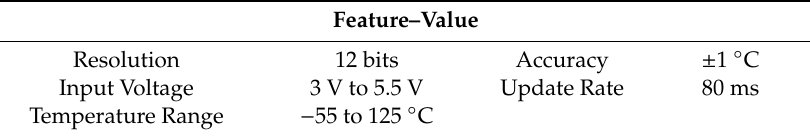
Table 2. Main characteristics of the NCT75 temperature